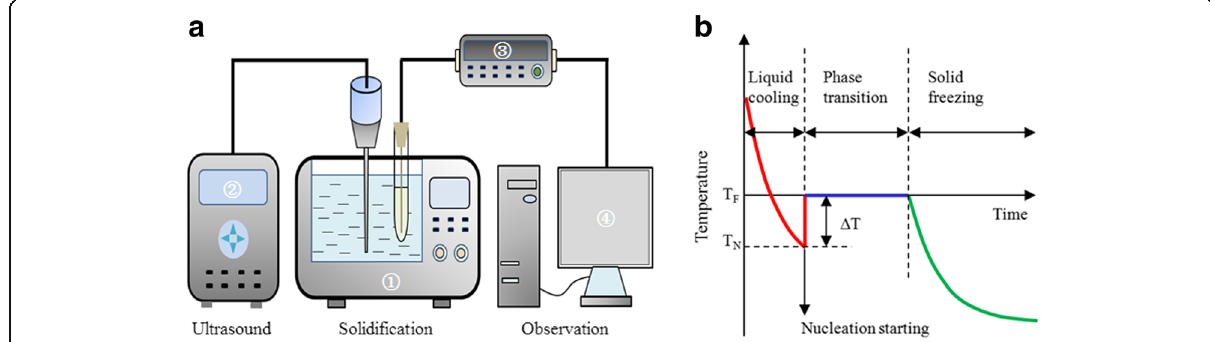
Fig. 2 a Schematic of the experimental apparatus: (1) thermostatic bath, (2) ultrasonic device, (3) temperature data logger, and (4) computer. b Typical temperature profile of water solidification: T F , freezing temperature; T N , nucleation temperature; and Δ T , supercooling degree (difference between T F and T N